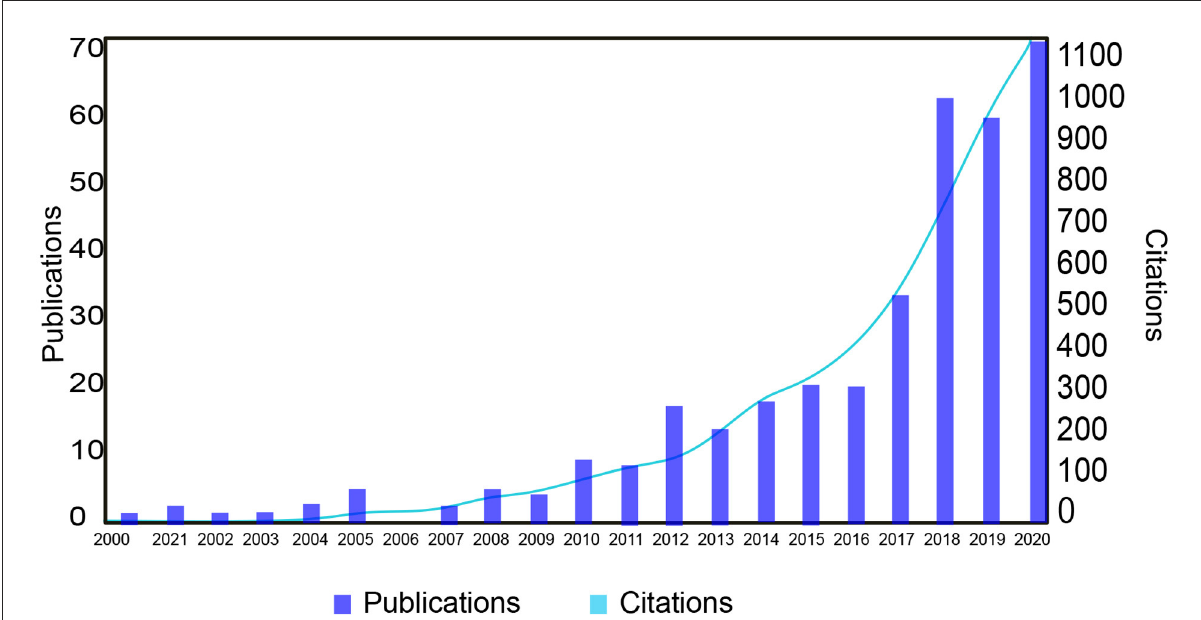
FIGURE3 Top countries developing research about labor in agri-food value chains between 2000 and 2020. Number above the country indicate the number of total publications identified in our database.